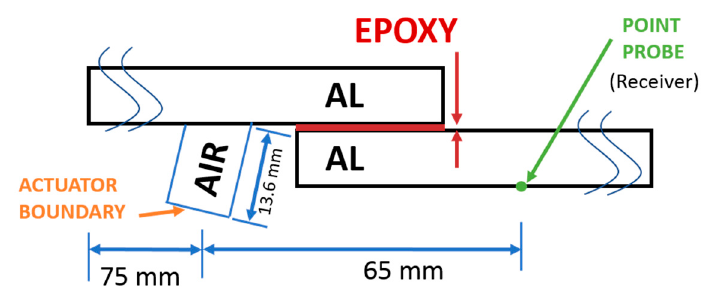
Figure 5. Schema of the simulation model for the air-coupled transducer to contact transducer guided wave.